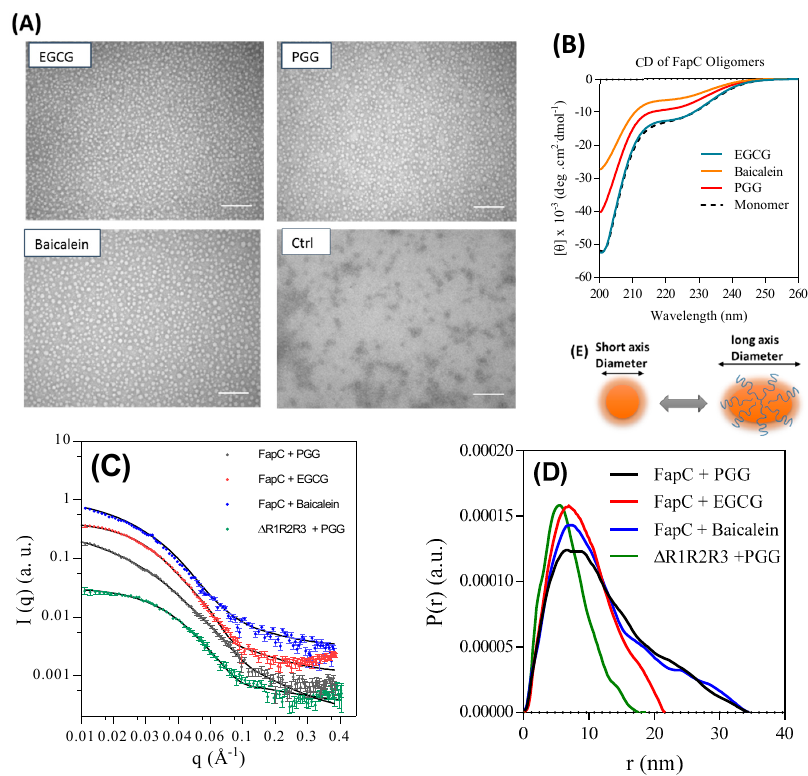
Figure 8. Structural analysis of off-pathway oligomers purified by SEC. ( A ) TEM image of oligomers show large spherical oligomers in the presence of inhibitors, in contrast to the small oligomers formed in their absence. Scale bars are 200 nm; ( B ) far-ultra violet (UV) CD spectra of monomer and SEC-purified oligomers both show largely random coil; ( C ) small-angle X-ray scattering (SAXS) data (scattering intensity I (q) versus length of scattering vector (q)) for purified oligomers all show the same overall shape; ( D ) pair distance distribution functions for the oligomers from panel c; ( E ) schematic representation of a possible monomer arrangement in the oligomer. Table 1. SAXS data for monomers and SEC-purified oligomers of FapC.